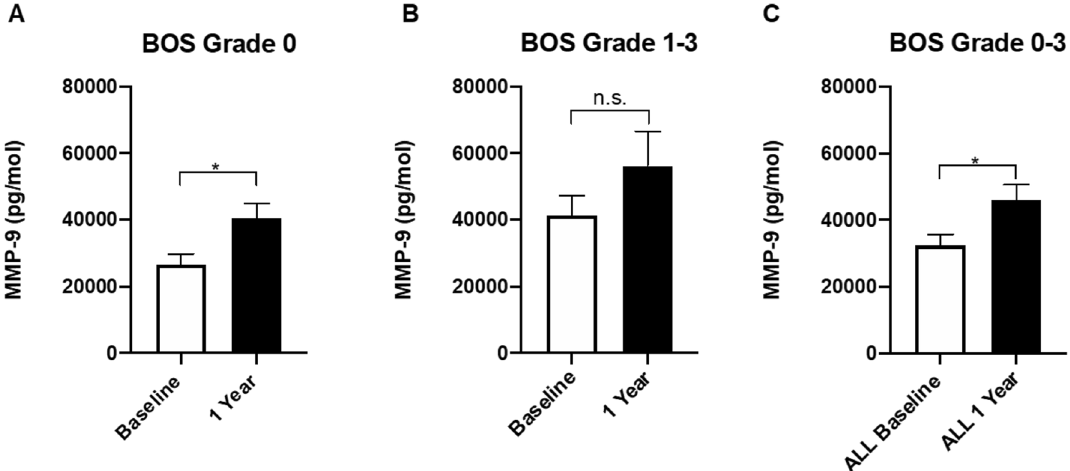
Figure 5. Elevation of MMP within BOS groups. Following patients from baseline to 1 year, MMP-9 levels in plasma increased within grades of BOS. This increase was statistically signifcant in BOS grade 0 ( A ) and across all BOS grades 0–3 grouped together ( C ). When BOS grades 1–3 were examined ( B ), a non-statistically significant increase can be appreciated. * p < 0.05. MMP-9, matrix metalloproteinase-9; BOS, bronchiolitis obliterans syndrome; ELISA, enzyme-linked immunosorbent assay.